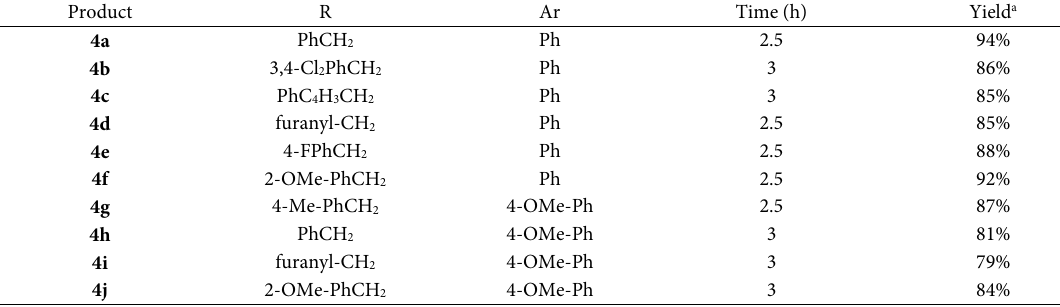
PW O -amino-functionalized CdFe 3 12 40